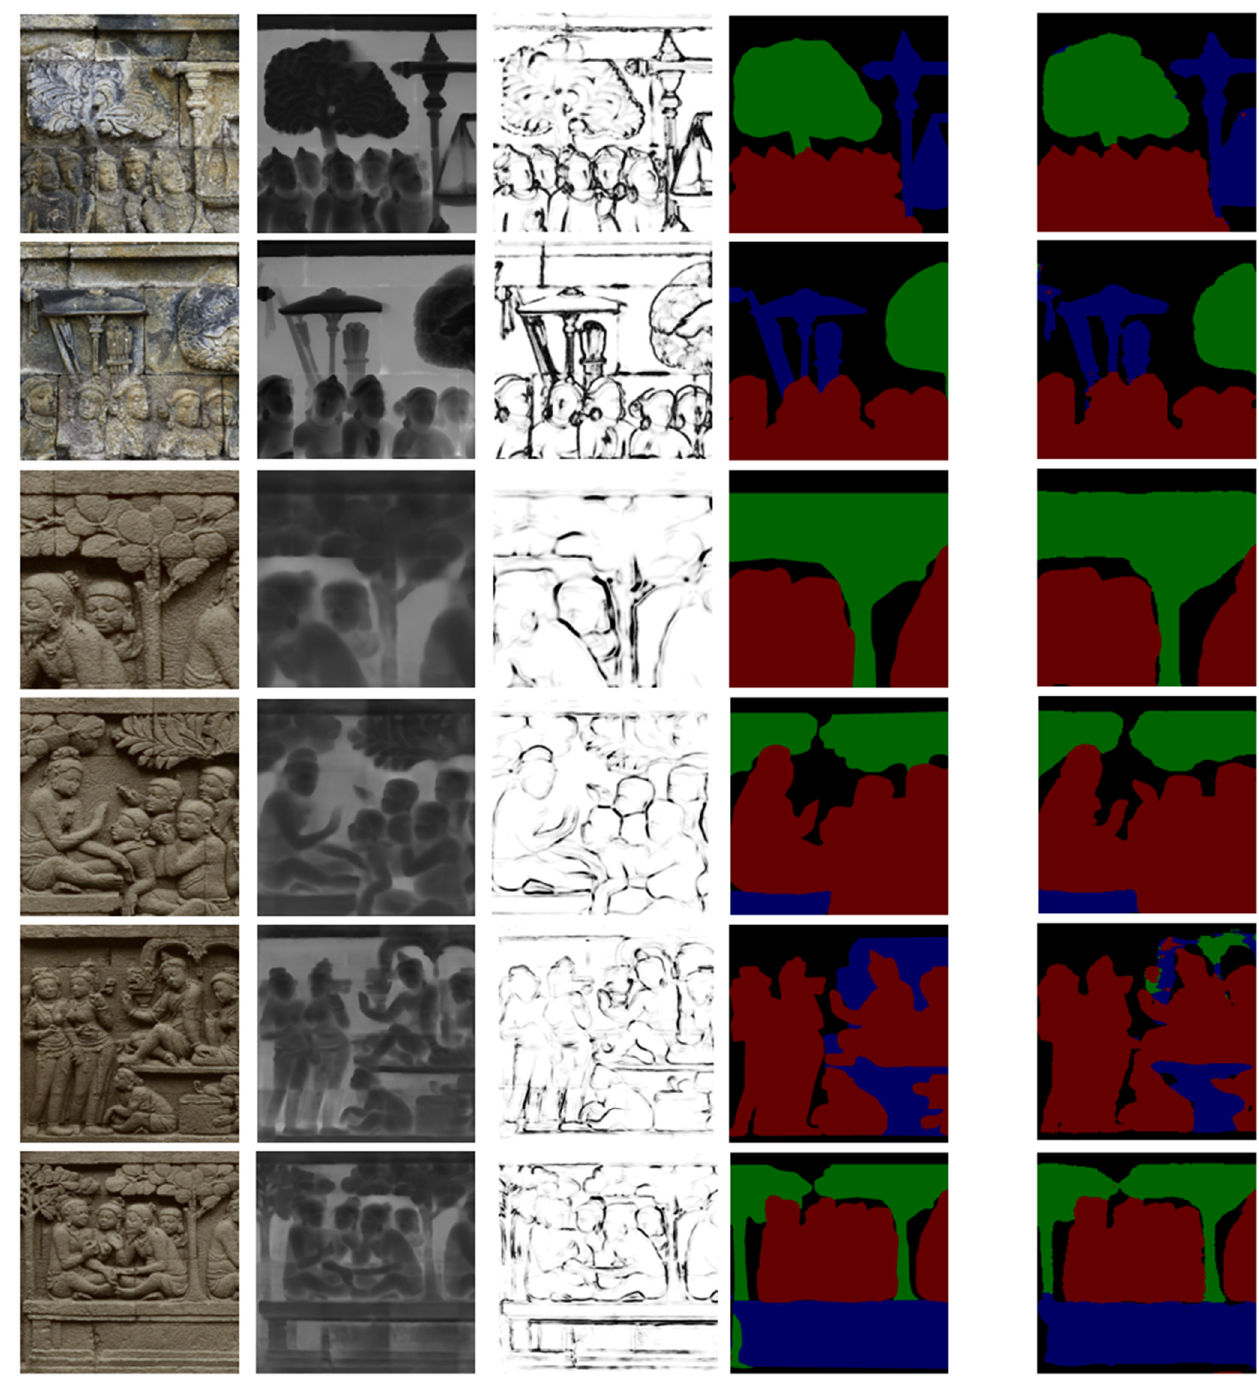
Figure 9. Predicted results on test data. Left to right: input RGB image, depth map, soft-edge, ground truth, and prediction results. The results show that our network is robust to different concentrations in soft